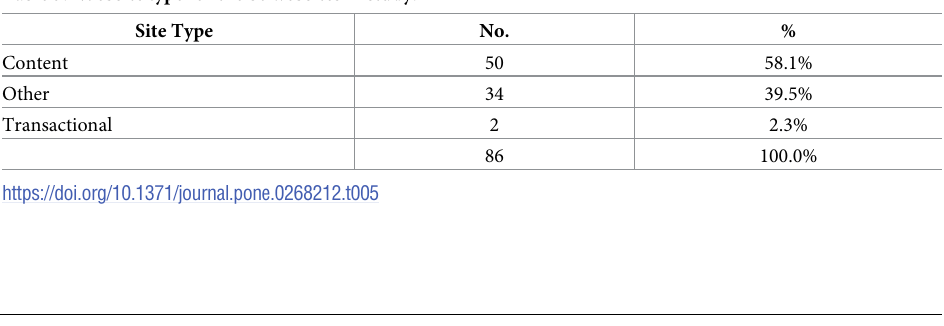
Table 5. Website type for the 86 websites in